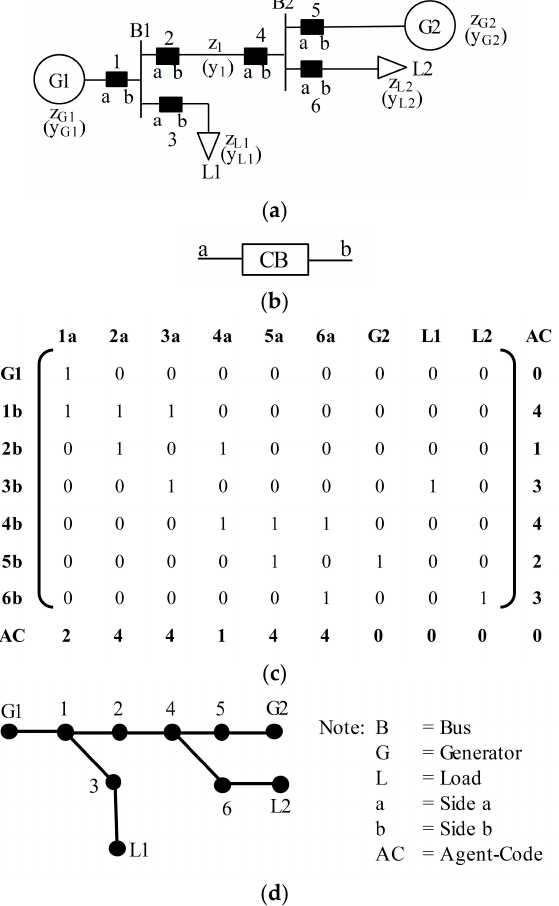
Figure 1. Construct TM model. ( a ) Example network; ( b ) CB model; ( c ) TM; ( d ) Topology graph.